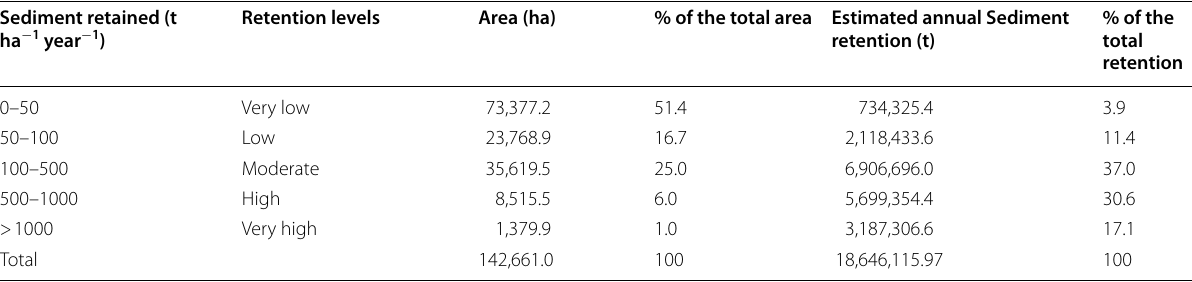
Table 7 Annual sediment retention levels, rates, and area coverage